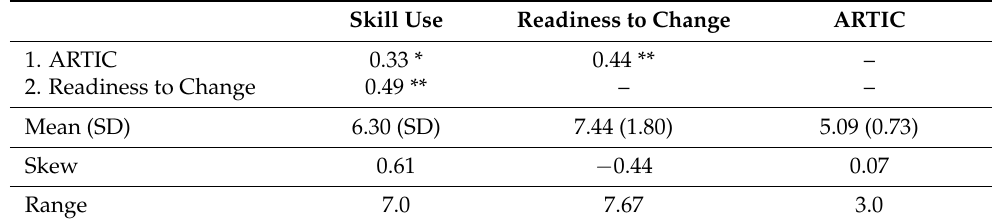
Table 1. Correlations among scores on the ARTIC, Readiness to Change, and Self-Reported Skill Use. Skill